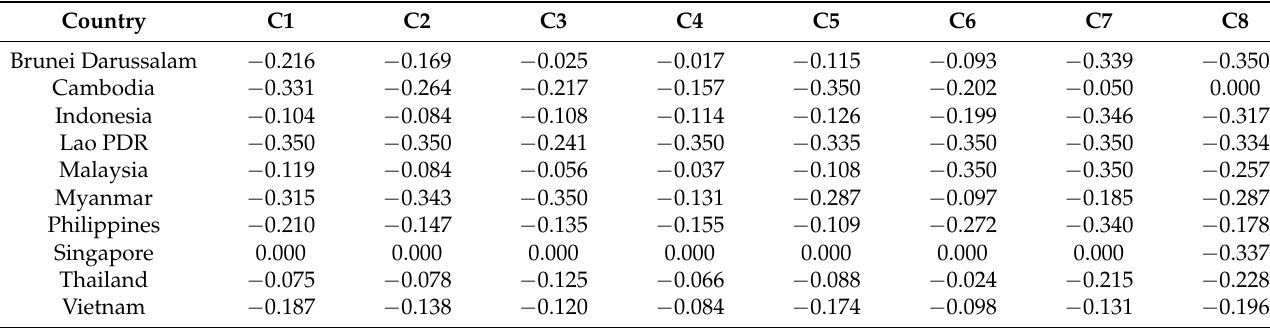
Table 5. Regret Utility matrix with Regret coefficient =